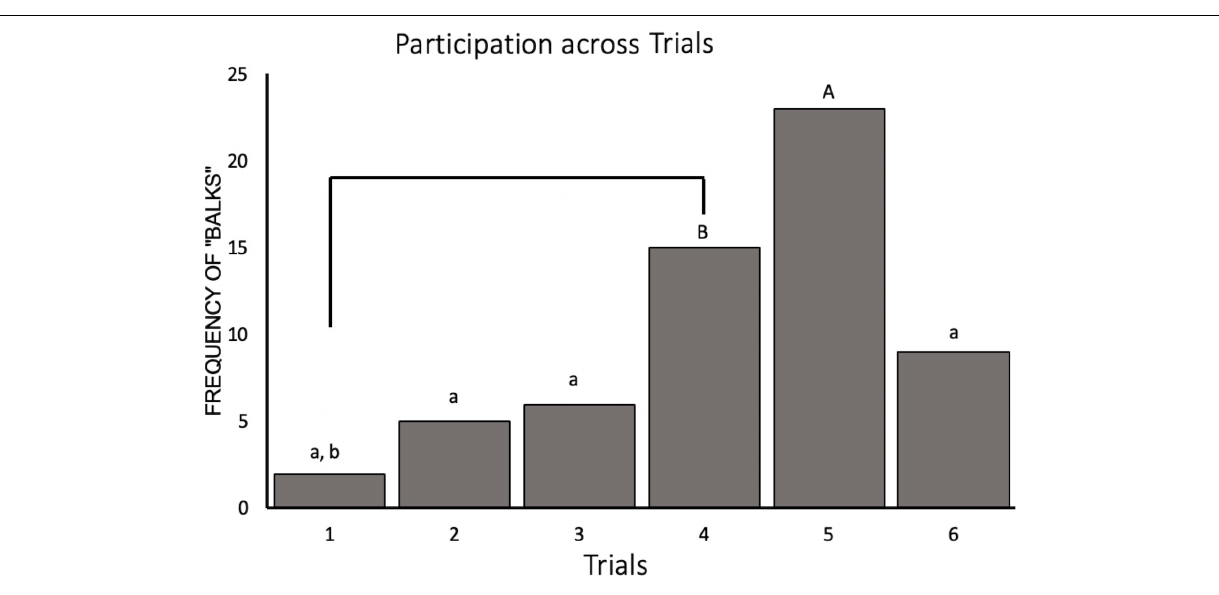
FIGURE 3 | Novelty response task participation ( N = 11) represented by the frequency of “balks” (i.e., instances where the animal refused to participate) plotted by trial. Trials labeled with a lower case “a” are significantly different from trial 5 (“A”) and trials labeled with a lower case “b” are significantly different from trial 4